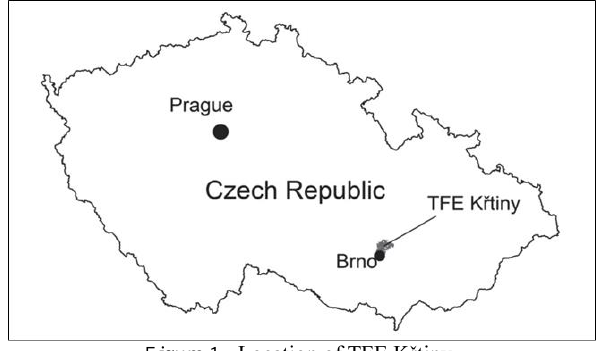
Figure 1. Location of TFE